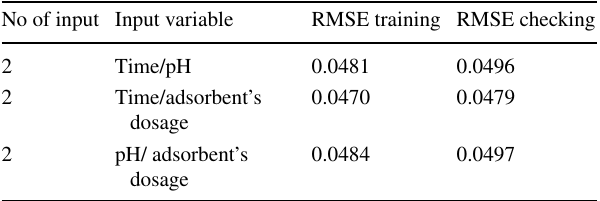
Table 7 Performance of different ANN models in estimating